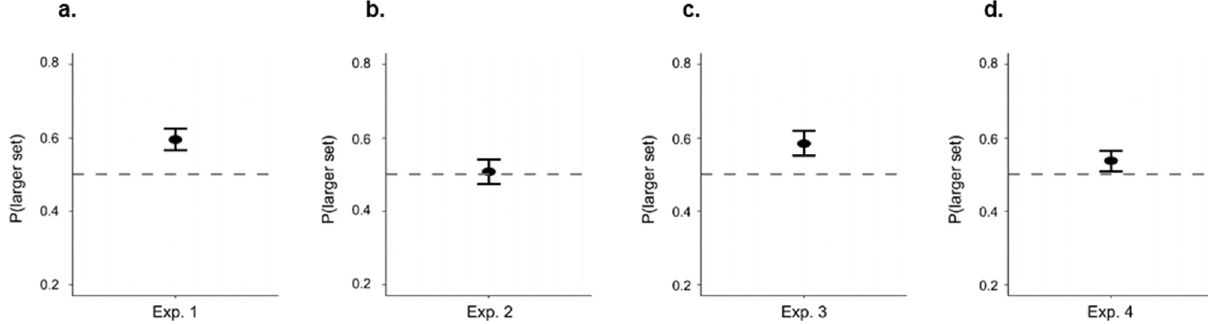
Figure 5. Probability of approaching the larger set during the test for each experiment. The dashed line indicates chance level (y = 0.50), the black bar represents the median, and the central dot repre- sents the mean.